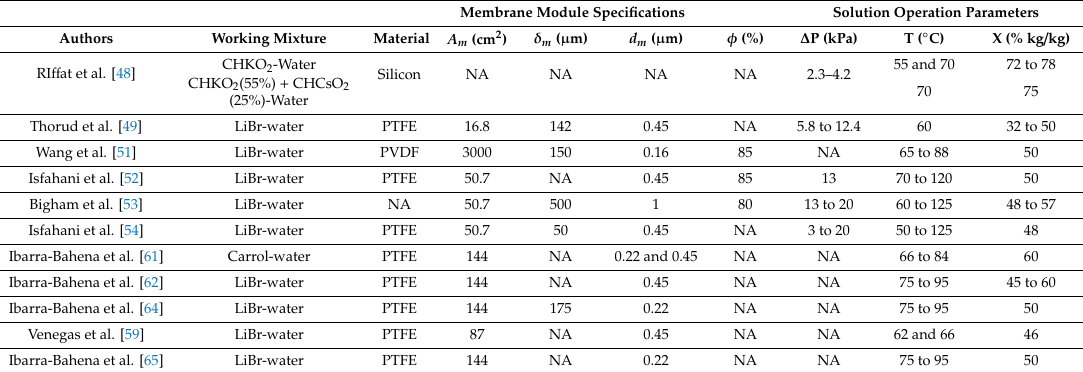
Table 1. Experimental work carried out on MD